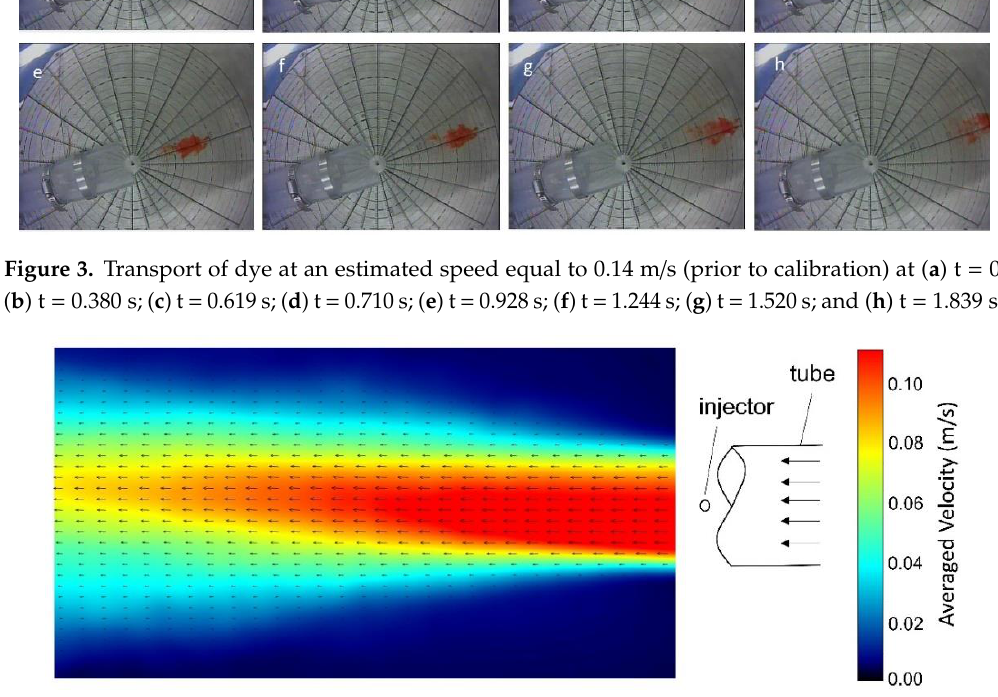
Figure 4. Particle image velocimetry (PIV) calculated velocity contour and vector field over the plate at a flow speed = 0.102 m/s.